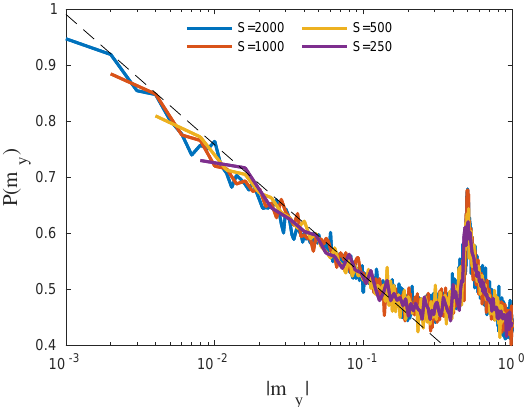
= S / S ≈ φ , Eq. 6, for the Lipkin- y y